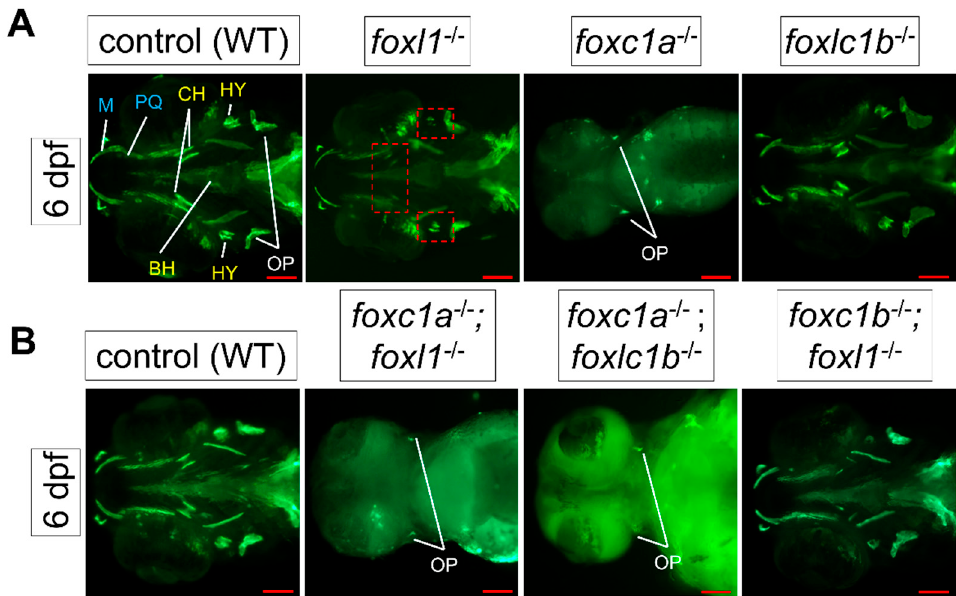
Figure 4. Calcein staining illustrating the impact of foxl1, foxc1a, and foxc1b lone and combined loss on craniofacial development and calcification. ( A ) foxc1a -/- embryos have a lack of bone development in all craniofacial bones resulting from the first (blue) and second (yellow) pharyngeal arches and diminished formation of the opercula bones at 6 dpf. foxc1b -/- embryos exhibit no change. foxl1 panels are included for reference. ( B ) WT ( n = 173); foxc1a -/- ; foxl1 -/- ( n = 6); foxc1b -/- ; foxl1 -/- ( n = 2); and foxc1a -/- ; foxc1b -/- ( n = 4) embryos at 6 dpf. foxc1a -/- ; foxl1 -/- embryos exhibit a further loss of craniofacial bone formation and calcification with increased size in the cardiac edema present, while foxc1b -/- ; foxl1 -/- embryos exhibit no change from their respective individual knockout models. foxc1a -/- ; foxc1b -/- double mutants show a similar phenotype as foxc1a -/- ; foxl1 -/- embryos. Red boxes highlight areas of interest. Small red squares highlight the hyomandibula and the large rectangular box isolates the ceratohyal bone. Scale bars are 100 µm.